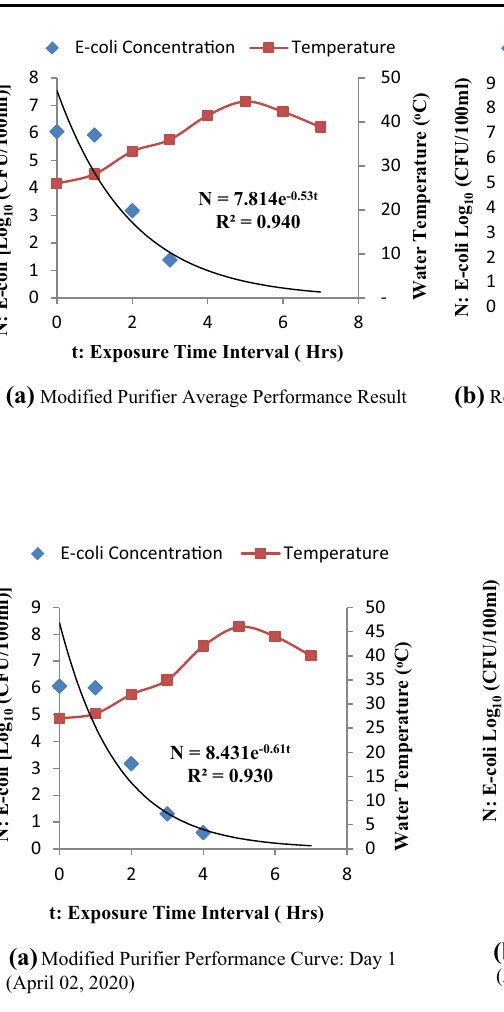
Fig. 9 a and b Day 2: Side-By- Side Performance Curves of the Improved SODIS and the Conventional SODIS